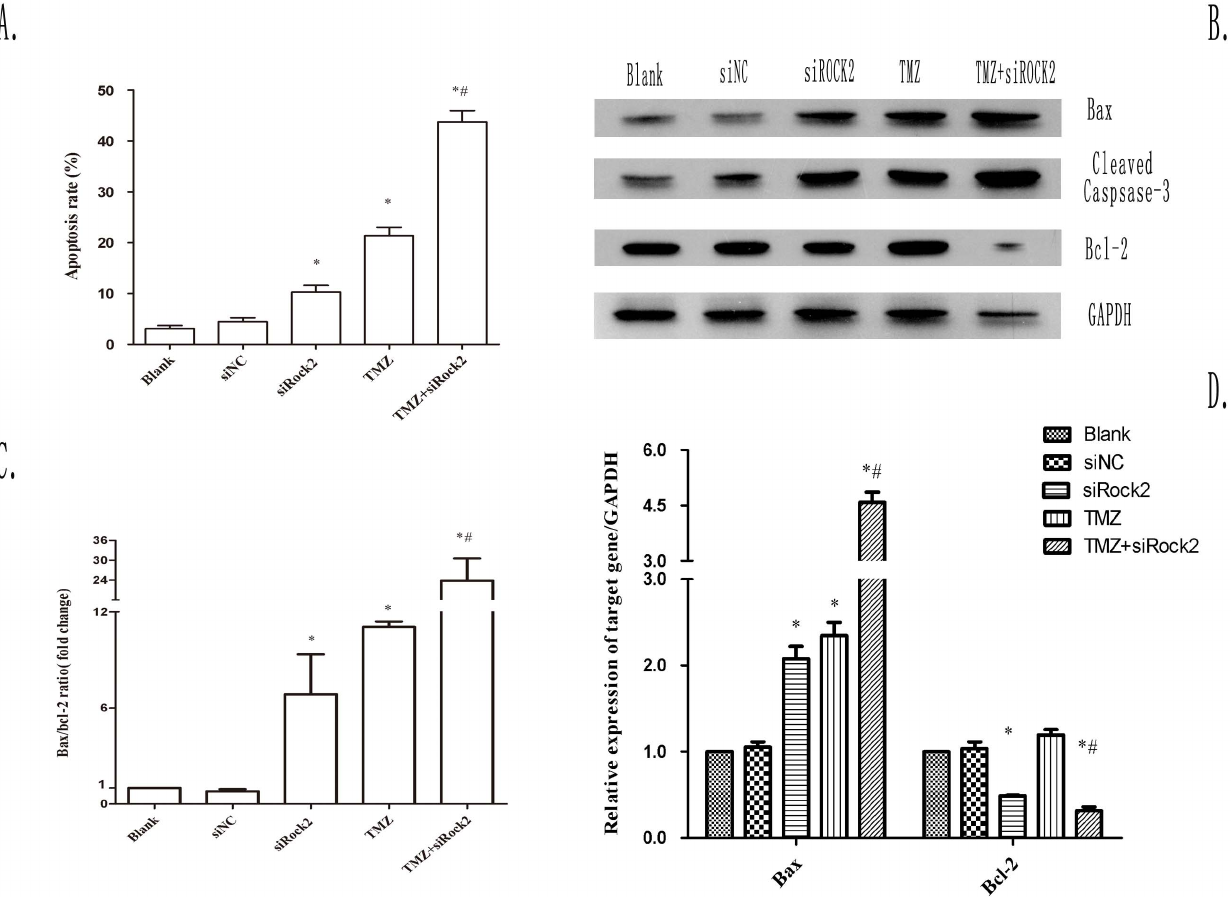
Figure 5. Combination treatment with TMZ and siROCK2 increases apoptosis in U251 cells. A The apoptosis rate was detected by flow cytometry using the Annexin V-FITC-PI double staining method. U251 cells were treated with siNC, siROCK2 complex, TMZ (100 m M), or the combination of the siROCK2 complex and TMZ (100 m M) for 48 h. B Representative Western blotting bands of Bax, cleaved caspase-3, and Bcl-2 in U251 cells treated as indicated. GAPDH was used as an internal standard. C Relative Bax/Bcl-2 ratio obtained from the corresponding Western blotting bands. D Relative mRNA expression of Bax and Bcl-2 in U251 cells treated with siNC, siROCK2 complex, TMZ (100 m M), or the combination of siROCK2 complex and TMZ (100 m M) for 24 h. The relative mRNA expression was determined by RT-PCR. GAPDH was used as an internal standard. The data are presented as the means 6 SD; n=3. * P , 0.05 compared with the blank; # P , 0.05 compared with siROCK2 or TMZ.